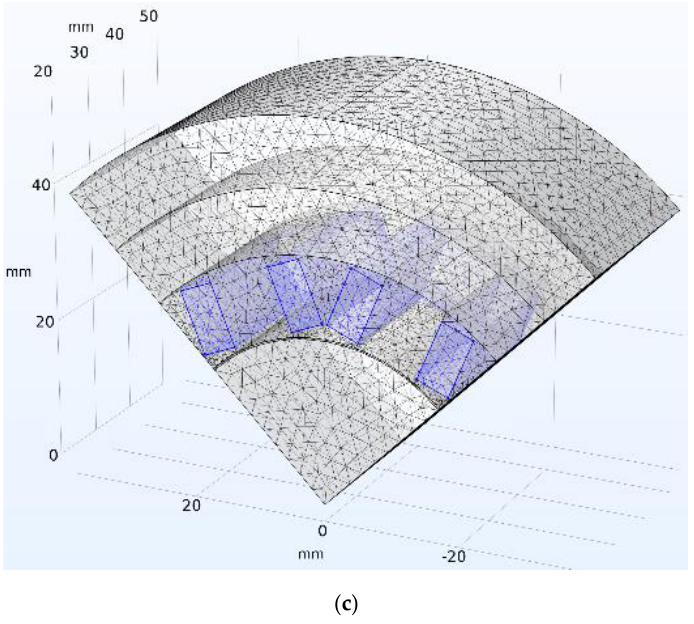
Figure 6. The mesh air gap ( a ), steel ET 140-30 ( b ), and coils of the electromagnet ( c ).